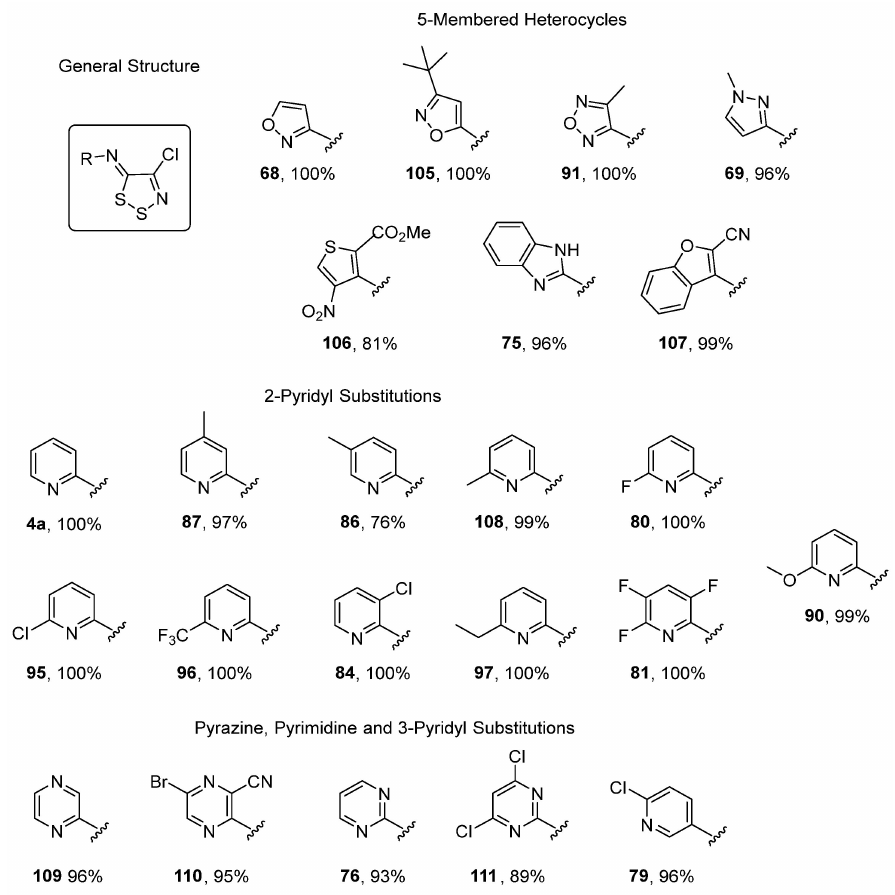
Figure 14. Venturiatest (apples) preventive; ≥ 70% efficacy at concentration of 250 ppm.